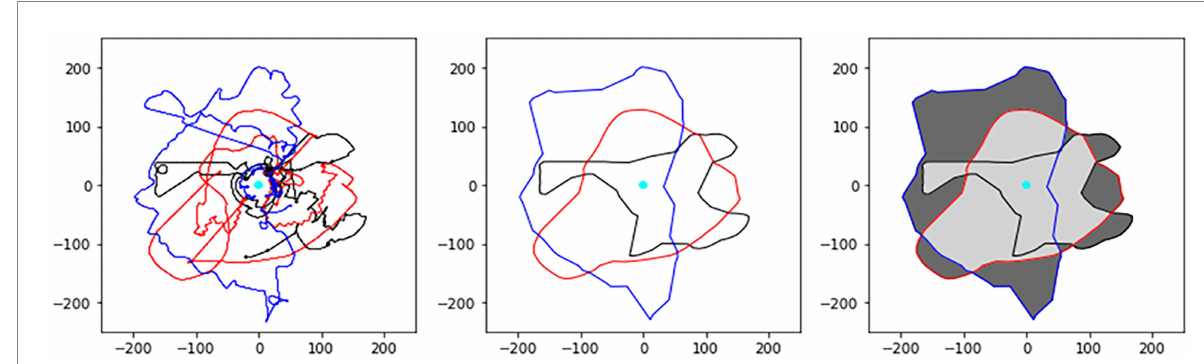
FIGURE 5 Illustration of how proportion overlap of player search was calculated. The position time series of each participant’s avatar (black, red, blue) (left) is submitted to the alphashape python toolbox. Concave polygons for each participant are then generated (middle), which represent the participants’ search areas. Polygon “fragments” are then obtained by taking the intersection of each pair-wise combination of participant search areas and then combined (light grey polygon in right panel). The proportion overlap of a team’s search area is then computed as the area of the light grey polygon divided by the total spread (represented as the sum of the dark grey and light grey polygons in the right panel). The cyan circle represents the location of the containment area. Adapted from Nalepka et al.